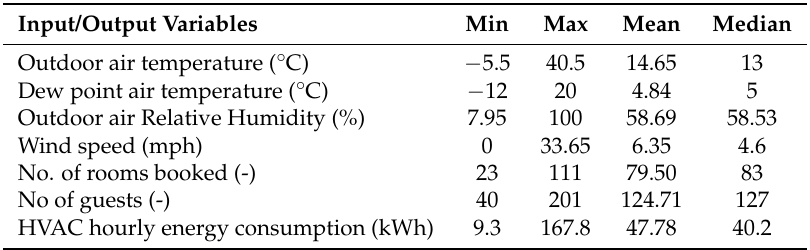
Table 1. Summary of the variables used for training and